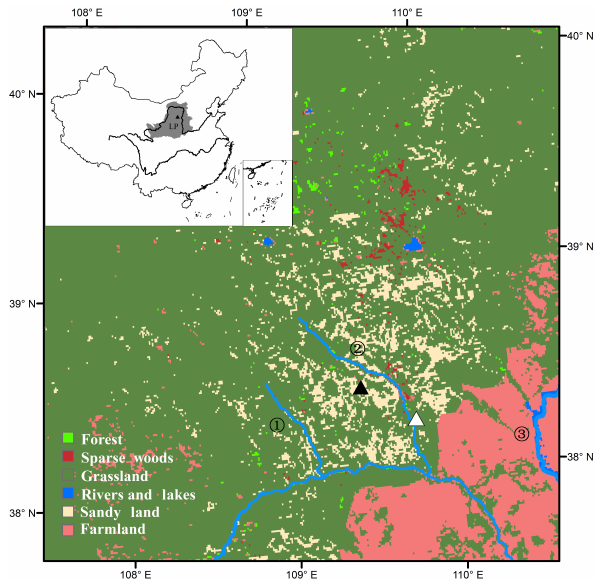
Figure 1. Location of the Loess Plateau and map of the study site (LP: the Loess Plateau; black triangle: flux tower; white tri- angle: Yulin meteorological station; (1): Tu River; (2): Yuxi River; (3): Yellow